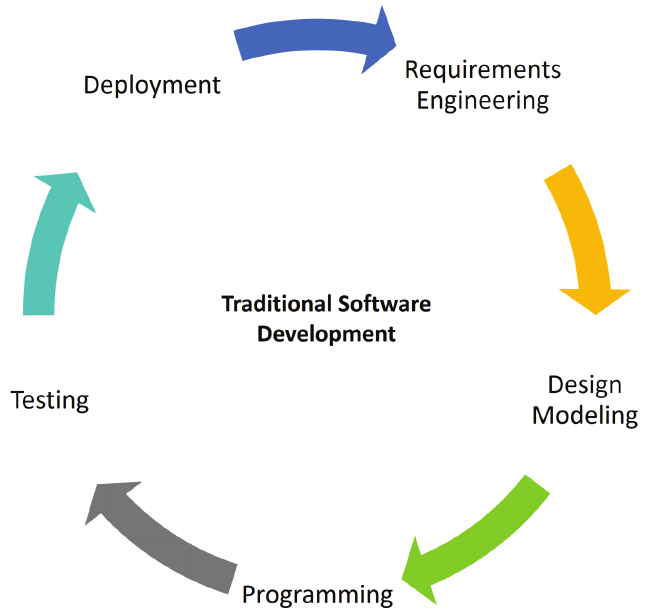
Figure 2. Traditional Software Development consisting of integrated and cyclic combination of the following independent modular approaches: requirements engineering, design modeling, programming, testing and deployment.